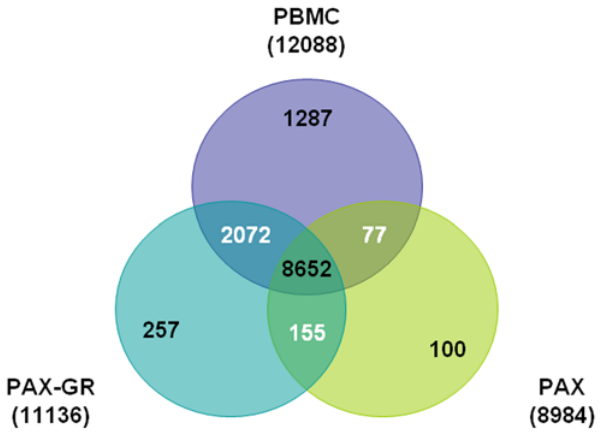
Figure 3. Detection of expressed transcripts in PBMC, PAX and PAX-GR in control (Grey bars) and SCD (Black bars) as determined by the present calls for the samples (n=5) analyzed by microarrays. Values are given as mean 6 SD for the number of present transcripts in each of the groups in each sample type.